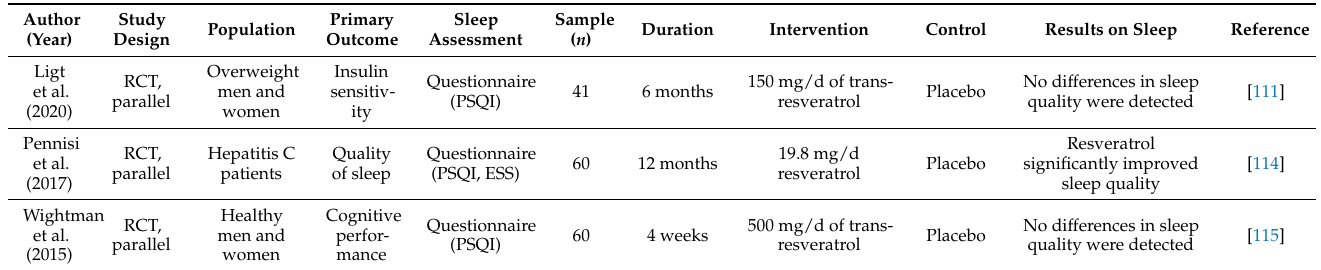
Table 2. Summary of human clinical studies assessing the association between sleep and resveratrol